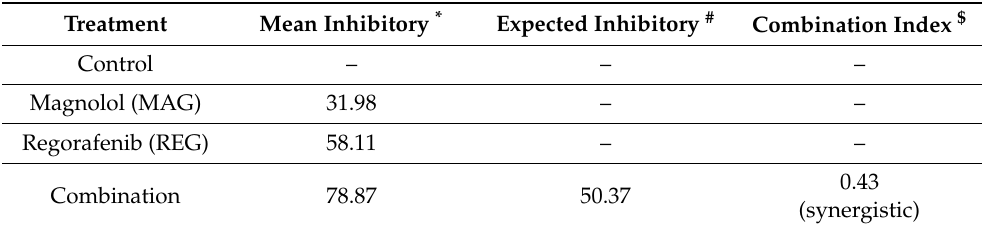
* Mean growth inhibitory rate: 1-mean tumor volume ratio of the treated group/mean tumor volume ratio of the sham control group on the 20th day. # Expected growth inhibitory rate: the inhibition rates of the combination minus the multiplication of both the MAG and REG inhibition rates. $ Combination index: 1-mean growth inhibitory rate of the combination/1-expected growth inhibitory